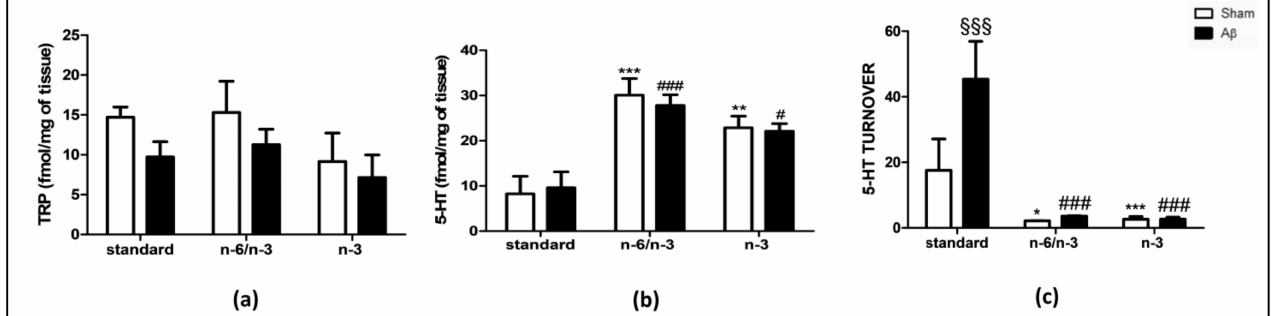
Figure 4. Effects of standard, n-6/n-3 PUFA balanced and n-3 PUFA enriched diets on TRP, 5-HT and 5-HT turnover levels in A β -treated rats. Measure of hippocampal TRP ( a , SHAM standard n = 5, A β standard n = 5, SHAM n-6/n-3 n = 5, A β n-6/n-3 n = 4, SHAM n-3 n = 6, A β n-3 n = 4), 5-HT ( b , SHAM standard n = 4, A β standard n = 4, >SHAM n-6/n-3 n = 6, A β n-6/n-3 n = 6, SHAM n-3 n = 6, A β n-3 n = 6) and 5-HT turnover ( c, SHAM standard n = 3, A β standard n = 3, SHAM n-6/n-3 n = 5, A β n-6/n-3 n = 6, SHAM n-3 n = 6, A β n-3 n = 6) contents in rats 7 days after A β icv injection (A β , 4 µ M, black bar) or vehicle (SHAM, 5 µ L, white bar) receiving, from conception until 8-weeks-old, standard, n-6/n-3 balanced or n-3 PUFA enriched diets. Two-way ANOVA followed by Bonferroni multiple comparison test, §§§ p < 0.001 A β -treated rats fed, either, with n-6/n-3 balanced and n-3 PUFA enriched diets versus SHAM> rats; * p < 0.05, ** p < 0.01, *** p < 0.001 SHAM rats fed with n-6/n-3 balanced and n-3 PUFA enriched diets versus SHAM standard diet; # p < 0.05, ### p < 0.01 A β -treated rats fed with n-6/n-3 balanced and n-3 PUFA enriched diets versus A β standard diet. Data were expressed as means ± mean standard error